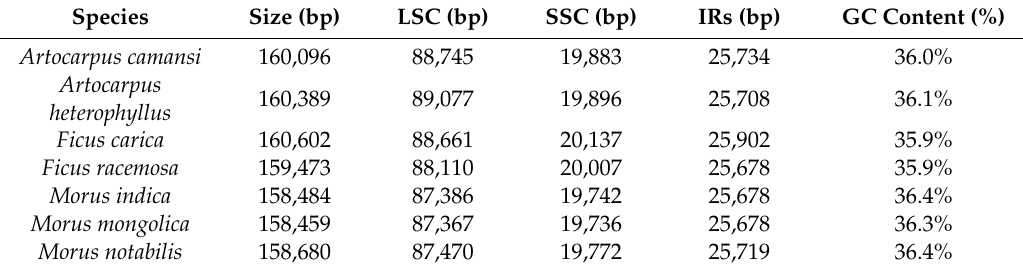
Figure 1. Gene map of the A. camansi plastid genome. The genes are color-coded according to their functional groups. The genes on the inside of the circle are transcribed in the clockwise direction, and those on the outside are transcribed counterclockwise. The inner circle shows the quadripartite structure of the chloroplast, that is, the small single copy (SSC), large single copy (LSC), and pair of inverted repeats (IRa and IRb). The darker and lighter gray shading in the inner circle correspond to guanine-cytosine (GC) and adenine–thymine (AT) content, respectively. Table 1. Basic parameters of the plastid genome of the newly assembled A. camansi and other species of the family Moraceae.